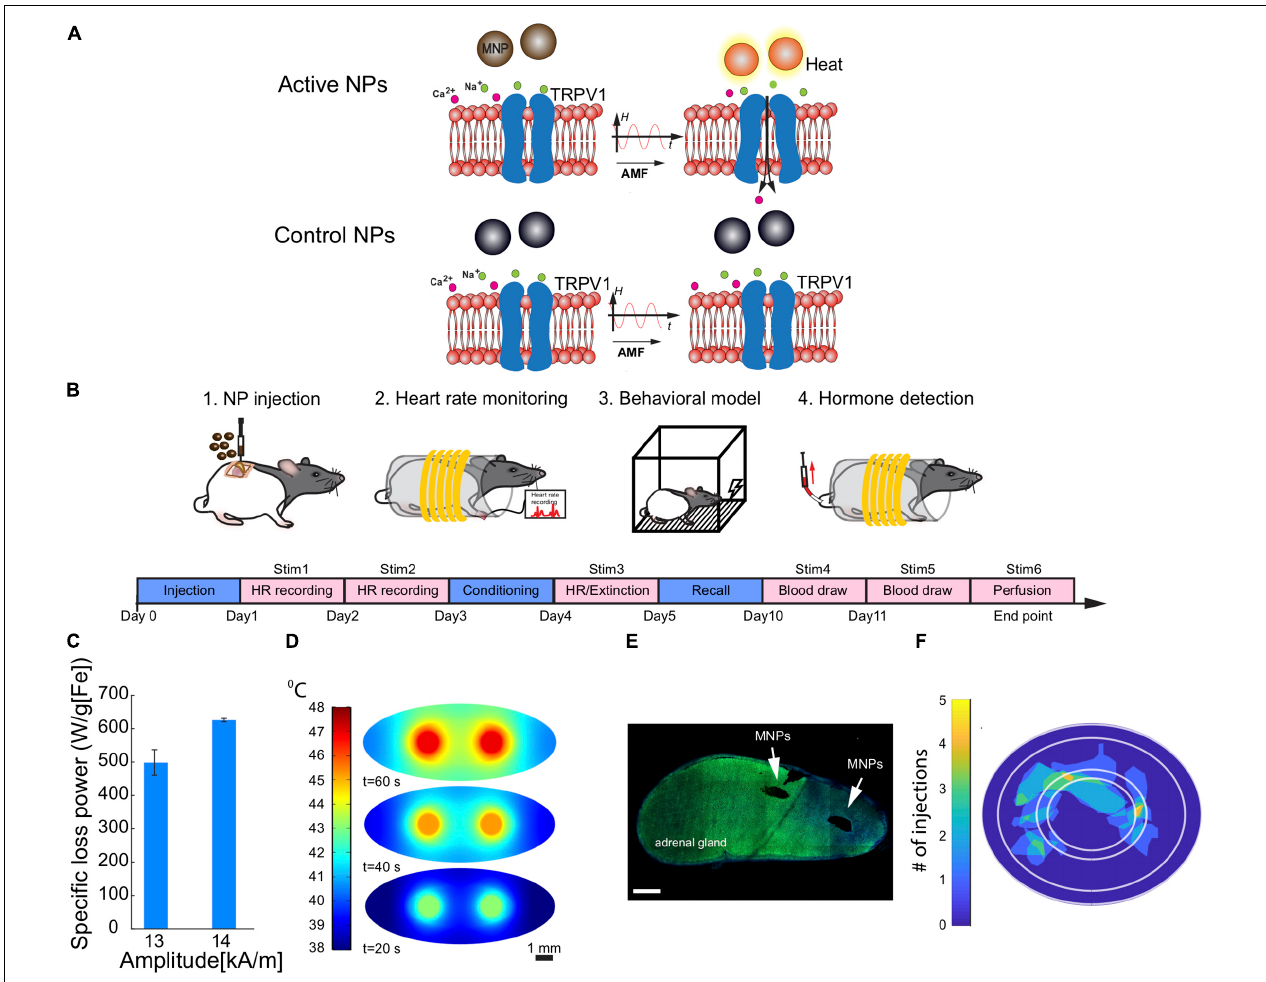
FIGURE 1 | Experimental design. (A) When an alternating magnetic field (AMF) is applied, the magnetic nanoparticles dissipate heat that causes the opening of heat-sensitive calcium-permeable ion channels (TRPV1 receptors). The calcium influx causes E and CORT release from adrenal cells. (B) Schematic diagram of the procedures that were performed in order. 1. Adrenal MNP injections. 2. Heart rate monitoring before and during magnetothermal stimulation. 3. Aversive conditioning and extinction. 4. Serum collections during magnetothermal stimulation for hormone analyses. The experimental timeline was as follows: After adrenal MNP injections, heart rate monitoring took place during MNP stimulation for 2 days (days 1 and 2) before the 3-day behavioral testing (days 3–5). Five days later, blood was collected for serum hormone (E and CORT) measurements (days 10 and 11). (C–F) Adrenal injection specifications and histology. (C) The specific loss power (SLP) of MNPs at a frequency of 624 kHz was estimated for two amplitudes (13 and 14 kA/m) that were measured within the coil. (D) Finite element modeling of temperature increases at 2 small-volume MNP injection sites within the adrenal gland at 20-s, 40-s, and 60-s of AMF applied. Scale bar = 1 mm. (E) Representative mosaic of an adrenal gland section with two MNP injections (two black holes). Scale bar = 500 µ m. (F) A map of MNP and WNP (control) injection sites in the adrenal gland across all animals ( n = 16).